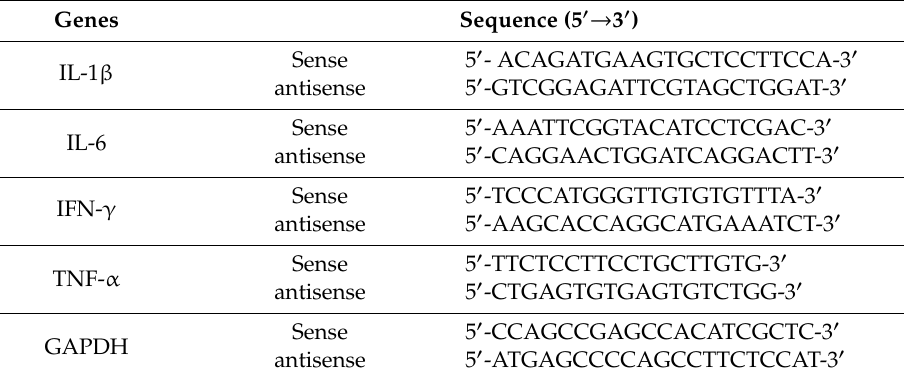
Table 2. Real-time PCR primer